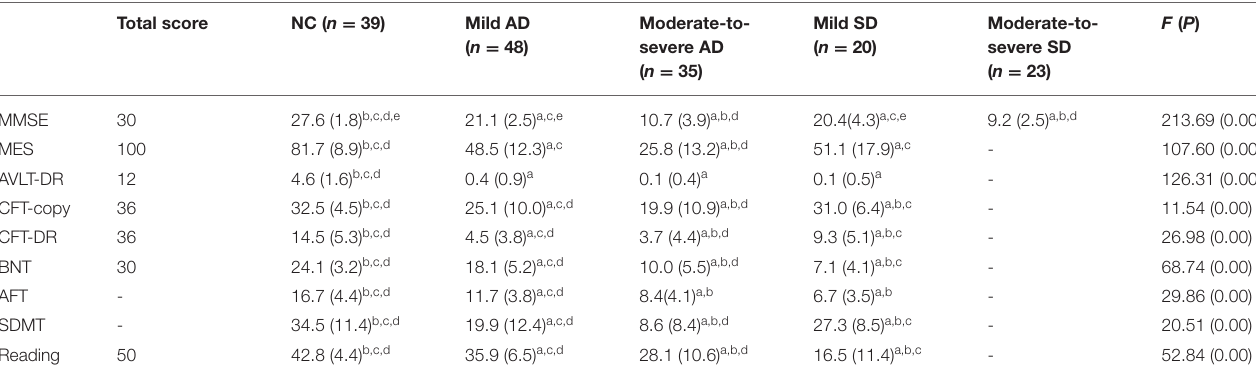
TABLE 2 | General neuropsychology of the five